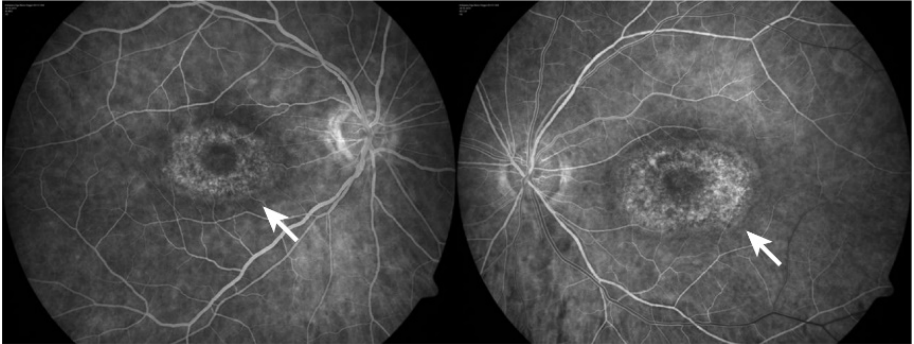
Figure 4. Hydroxychloroquine toxicity: white arrow shows presence of parafoveal zone of hyperfluorescence on fluorescein angiography.